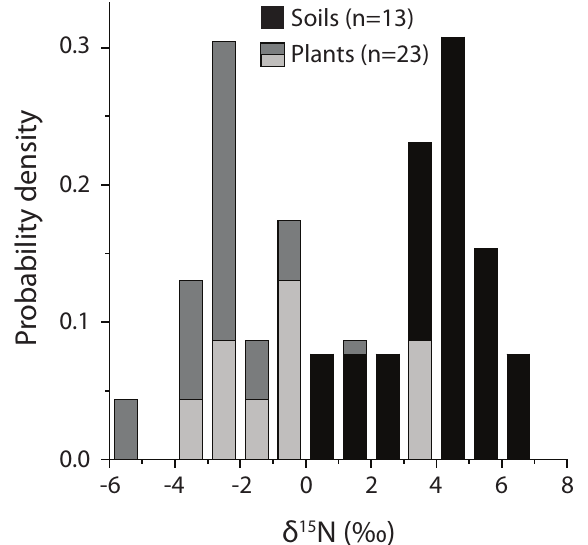
Fig. 2. δ 15 N of soil and plant organic matter from the Central Range, Taiwan. Probability density shown for soil (black), Pinus morrisonicola (dark grey) and Cymbopogon sp. (light grey).